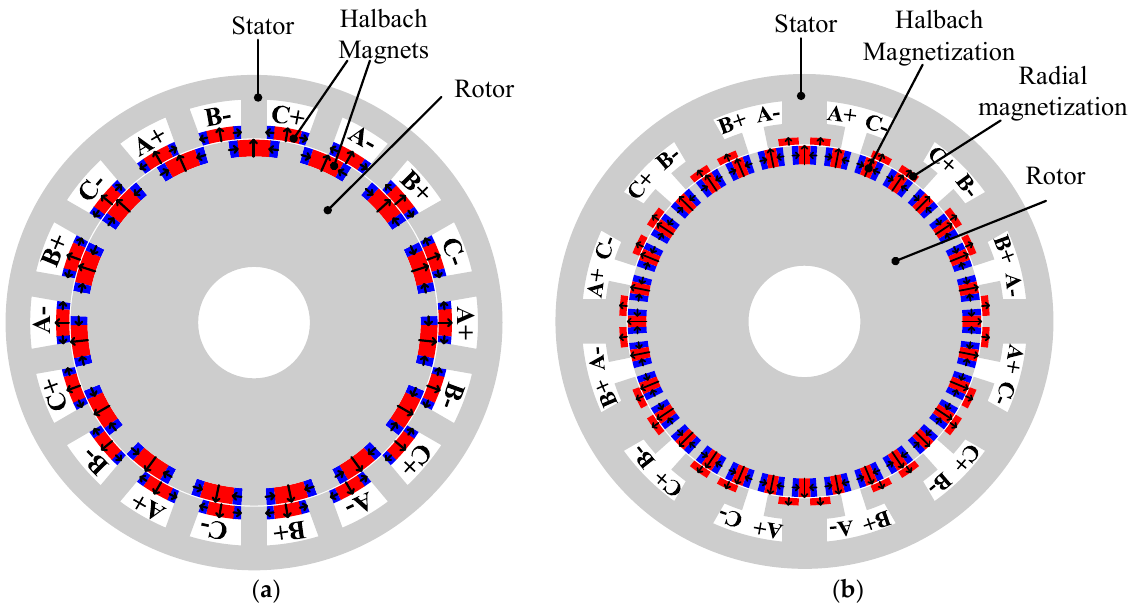
Figure 1. Machine topologies of dual permanent magnet (PM) machines. ( a ) 24S20R4Pa stator slot dual-PM (SSDPM) machine; ( b ) 12S20R4Pa split-tooth dual-PM (STDPM) machine.